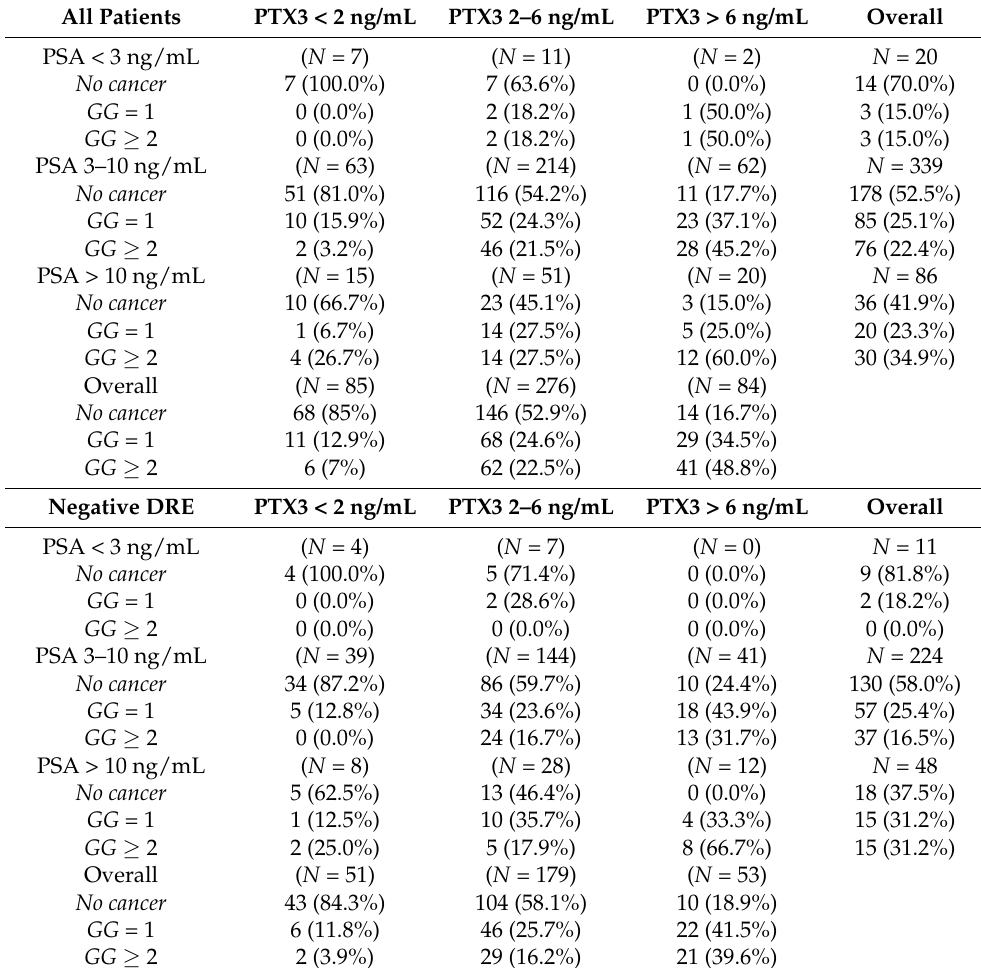
Table 4. Number of cancers by prostate specific antigen (PSA) and Pentraxin3 (PTX3)